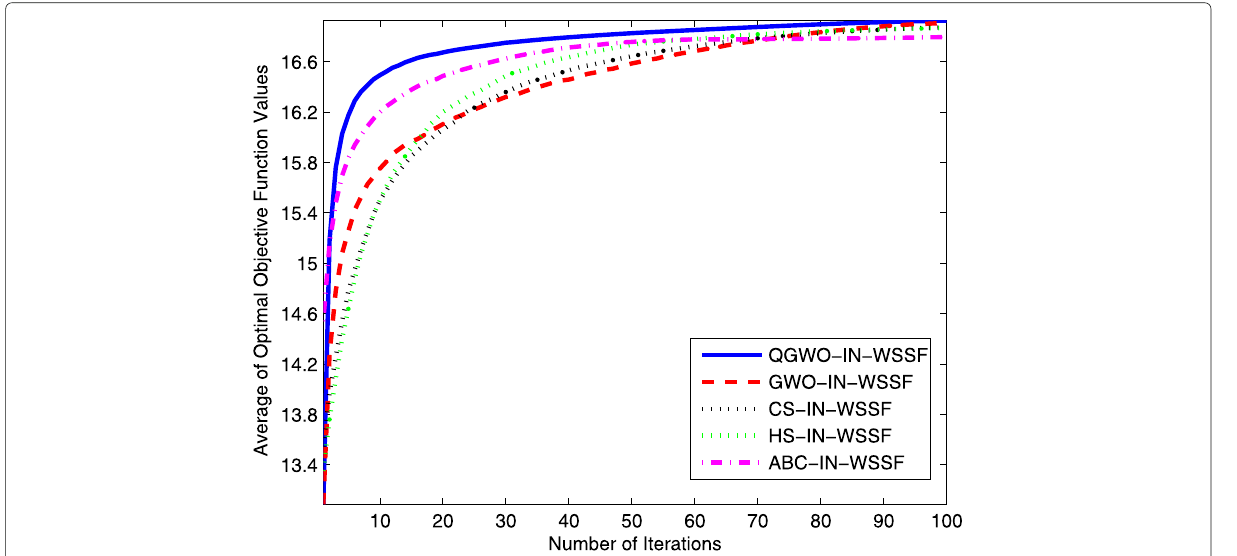
Fig. 3 Convergence curves of five intelligence algorithms for two independent sources with GSNR = 20dB and α =